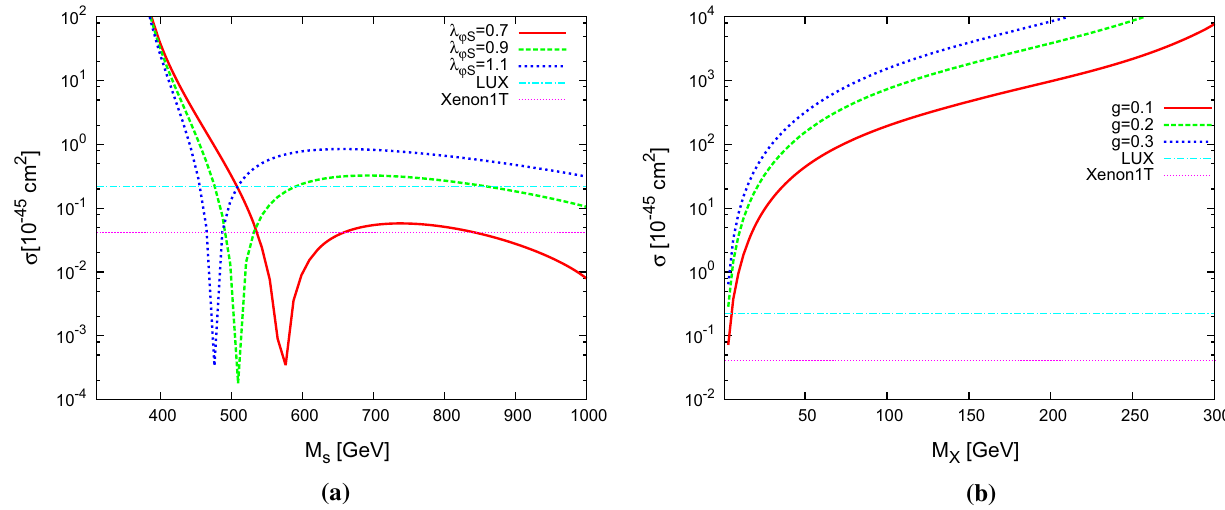
Fig. 5 The direct detection cross section as a function of mass of a scalar DM. We set M χ = 200 GeV and g = 0 . 2. b Fermion DM. We set